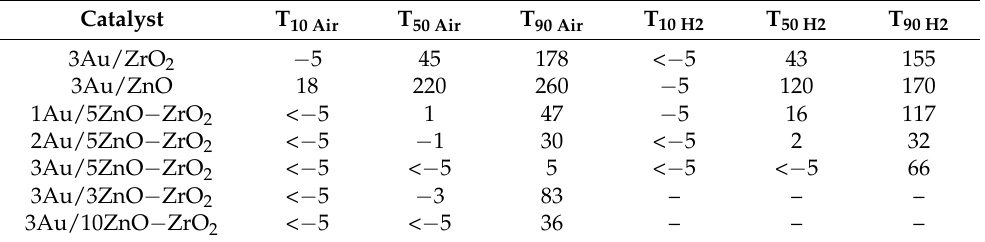
Table 3. Reaction temperature comparison to achieve 10, 50, or 90% of CO conversion of the different catalysts activated at 200 ◦ C under air and H 2 thermal